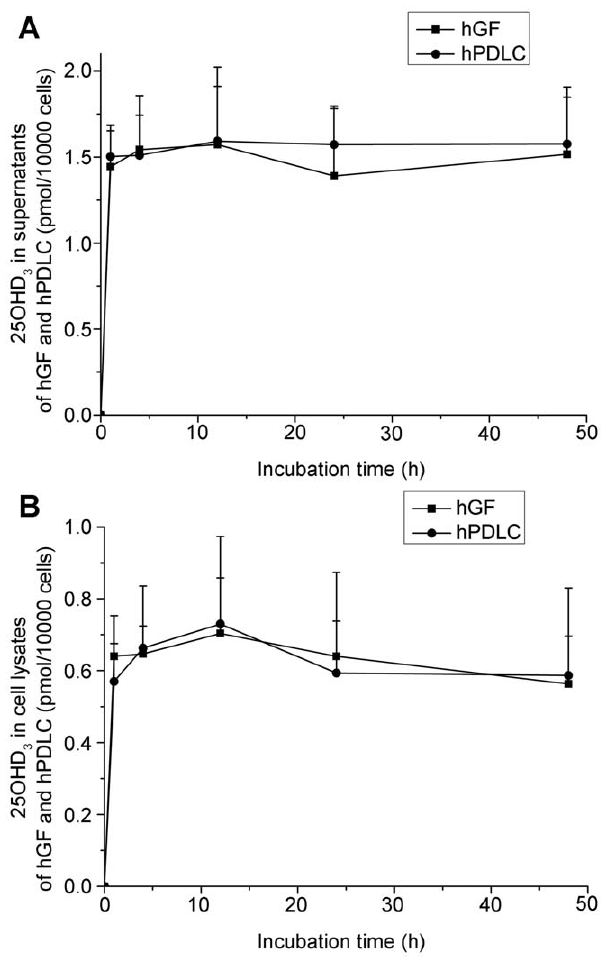
Figure 3. Activity of 25-hydroxylases in hGF and hPDLC. hGF and hPDLC from donors 2, 4 and 5 were incubated with 1000 nM vitamin D 3 for the times indicated, and the production of 25OHD 3 was determined in supernatants(A) and cell lysates (B). After incubation, the production of 25OHD 3 was detected. The amount of 25OHD 3 generated was not significantly different between hGF and hPDLC. The data are presented as the mean 6 SE.